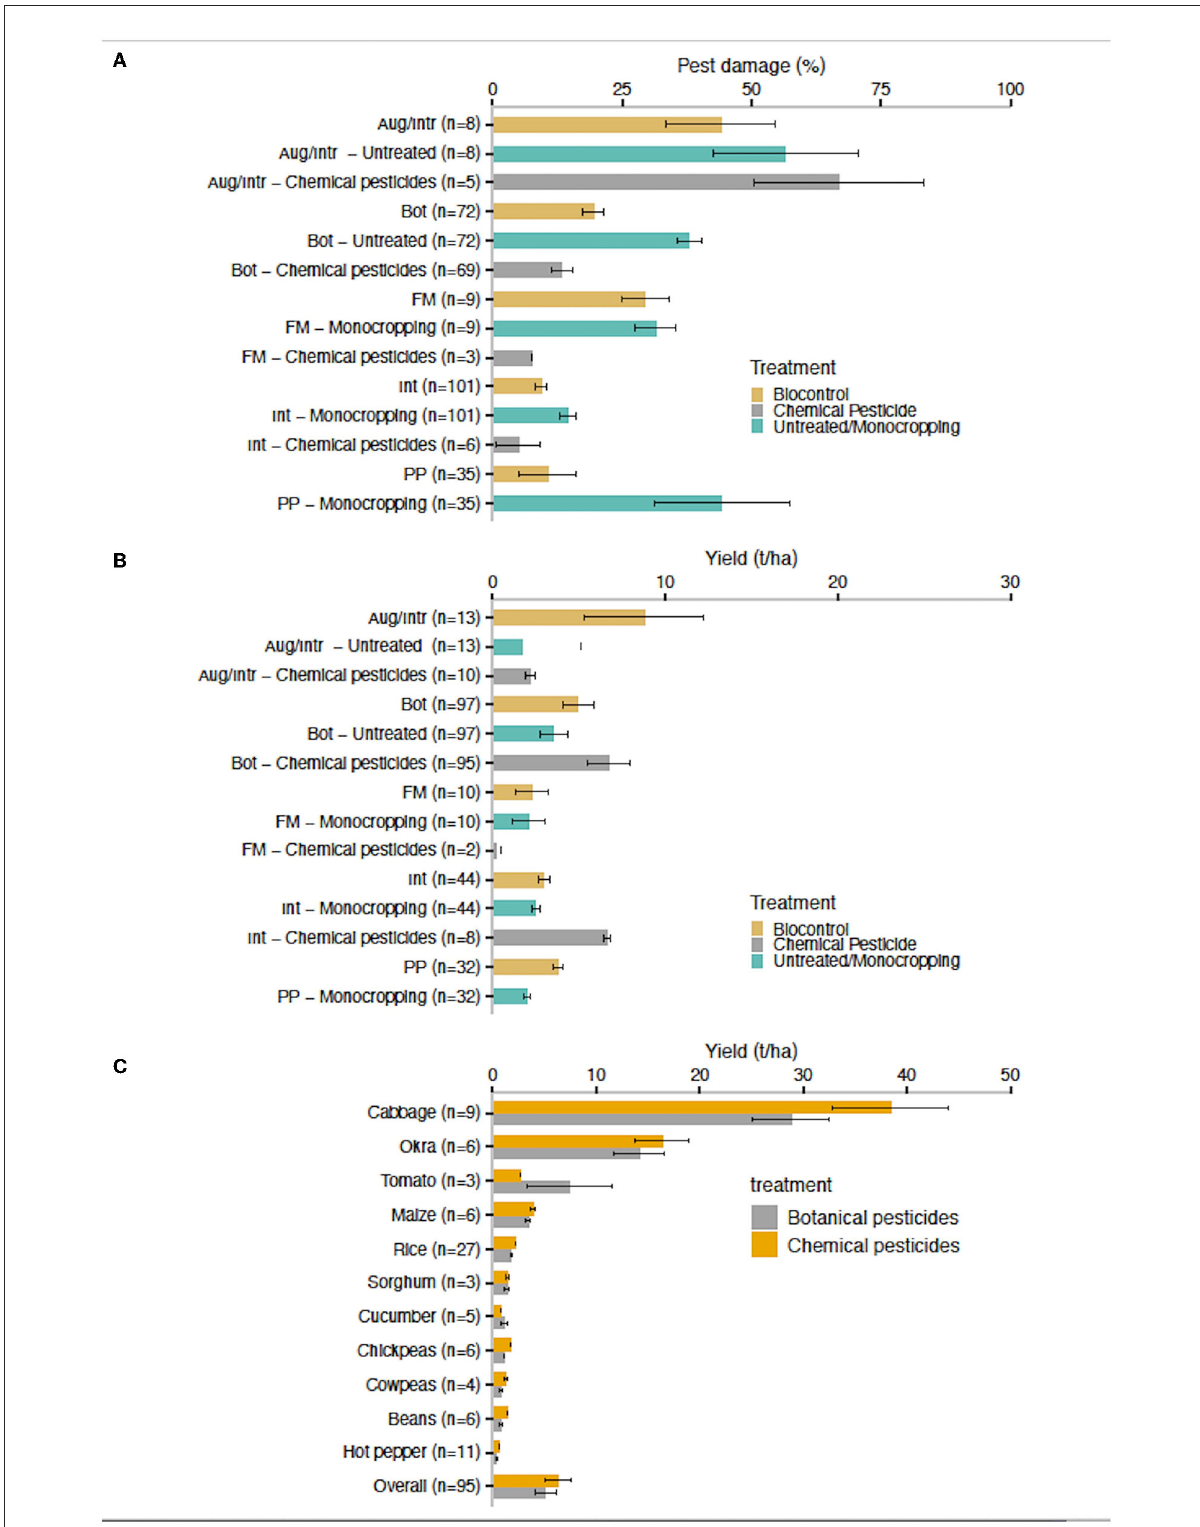
FIGURE4 Comparative changes in (A) pest damage, (B) yield across biocontrol intervention, and (C) comparative changes in yield between botanical and chemical pesticides. The means, 95% confidence intervals and n (that is the number of times that intervention was found in the 149 articles) are presented. Biocontrol performances are dependent on numerous factors, including within study conditions, which can result in heterogeneity between